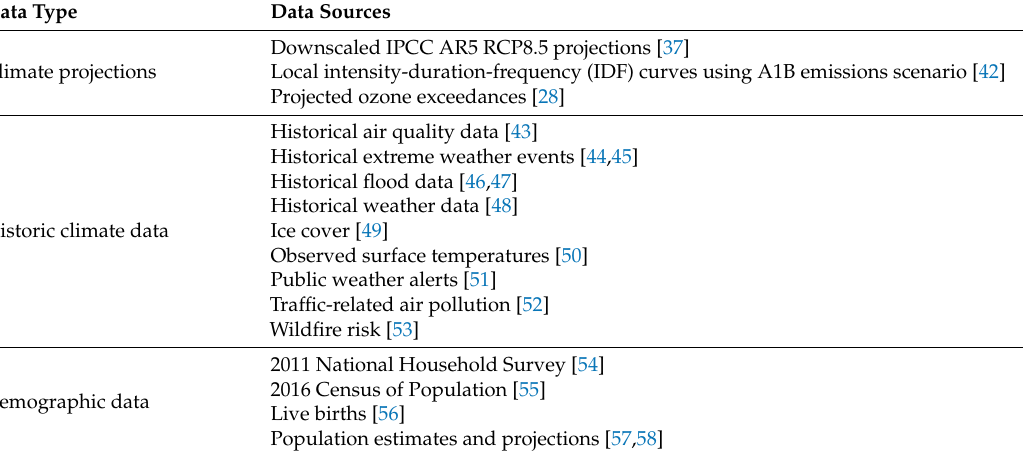
Table 2. Data types and associated sources included within the SMDHU climate change and health vulnerability